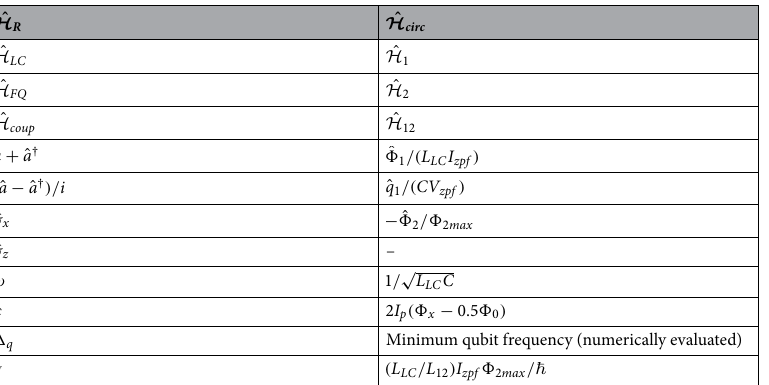
ˆ H ˆ H √ (cid:31) ω/( 2 L LC ) R and their counterparts in circ . I zpf = H 2 as functions of (cid:31) x and fitting the ˆ σ z and (cid:31) q ˆ